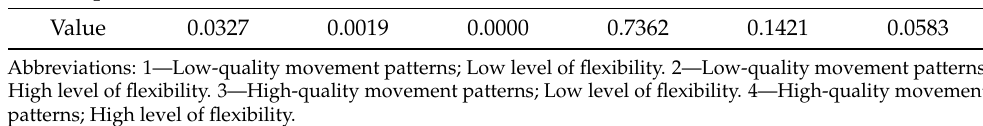
Table 4. Detailed comparisons between four groups—post hoc tests results.